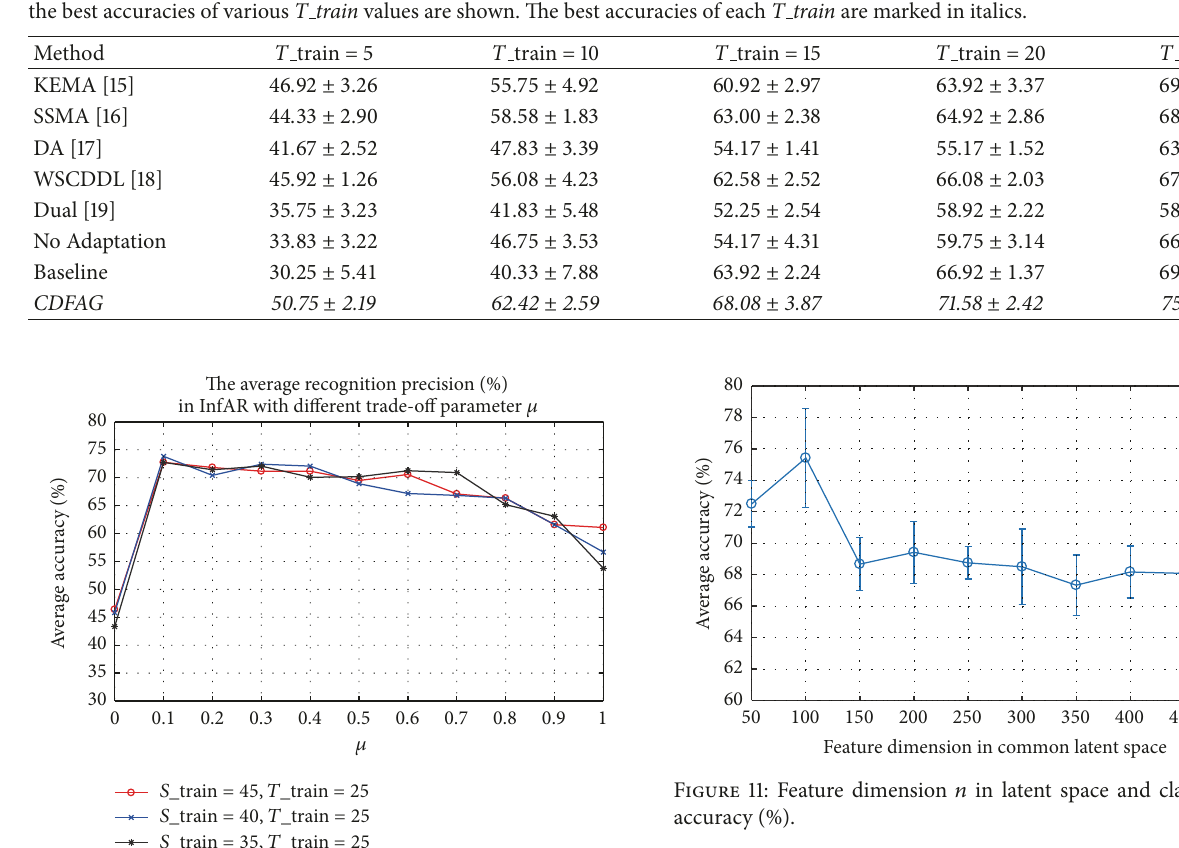
Figure 10: Trade-off parameter 𝜇 and the average recognition precision (%) in InfAR.